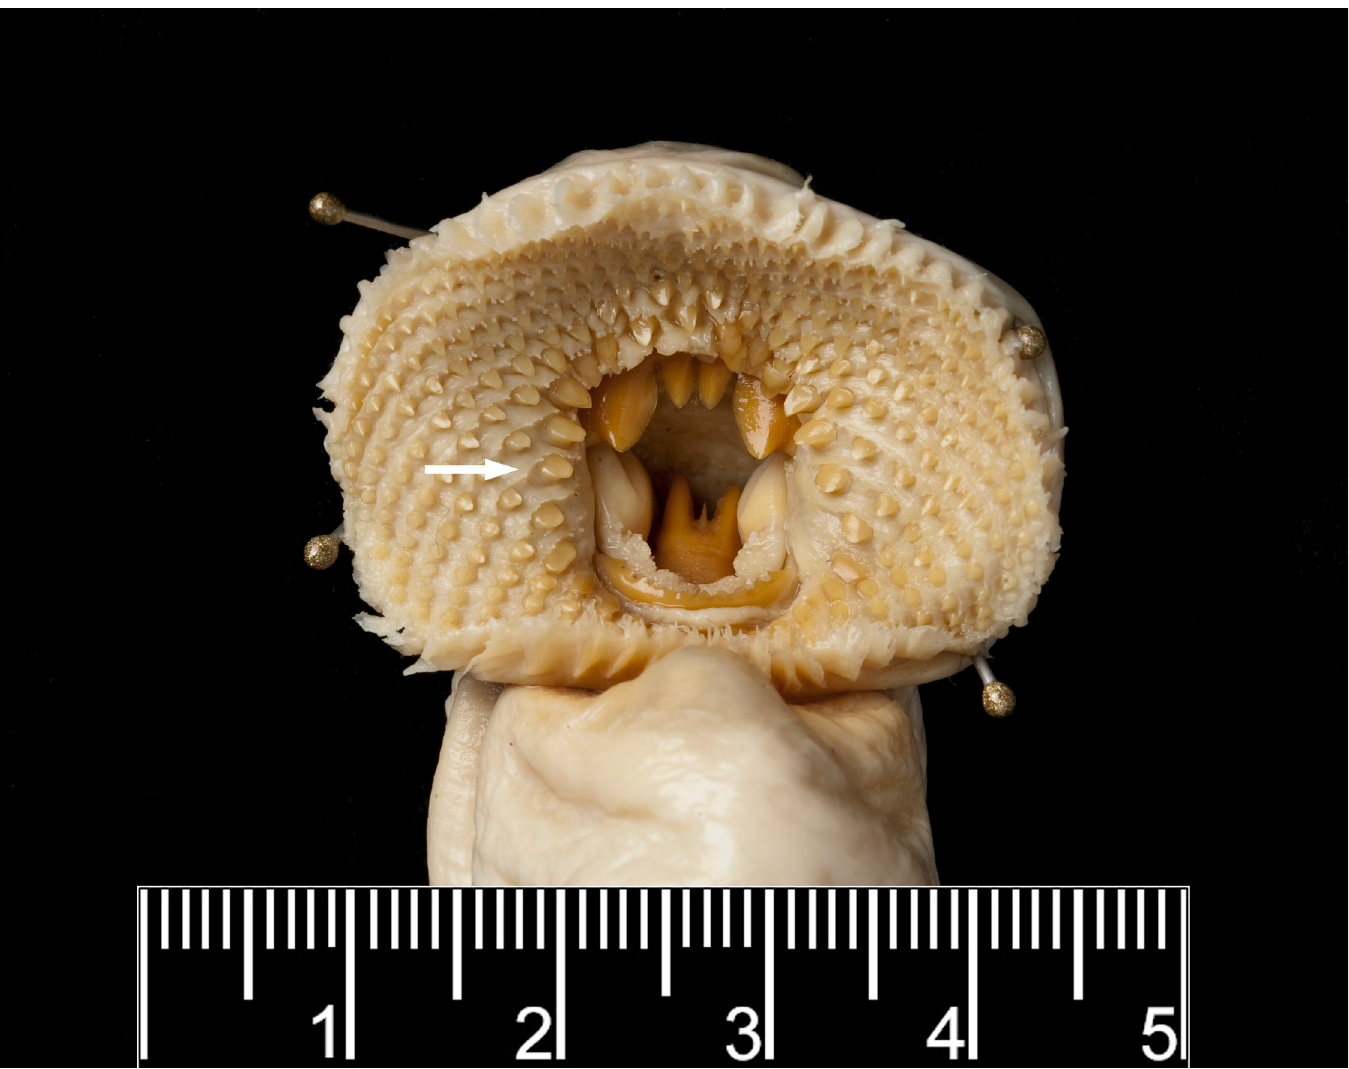
Fig 12. Oral disc of immature adult holotype of Geotria saccifera (BMNH 1886.11.18.112) showing the prominent ridges of epithelium flanking the labial teeth (arrow). Photographed by Phil Hurst, Photographic Unit, © The Natural History Museum, London.